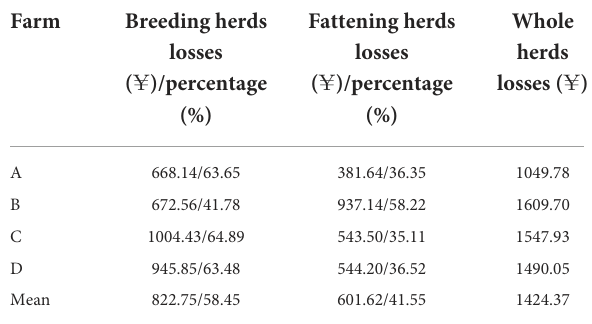
TABLE 4 The economic losses after the PRRS outbreak in the whole herds (per